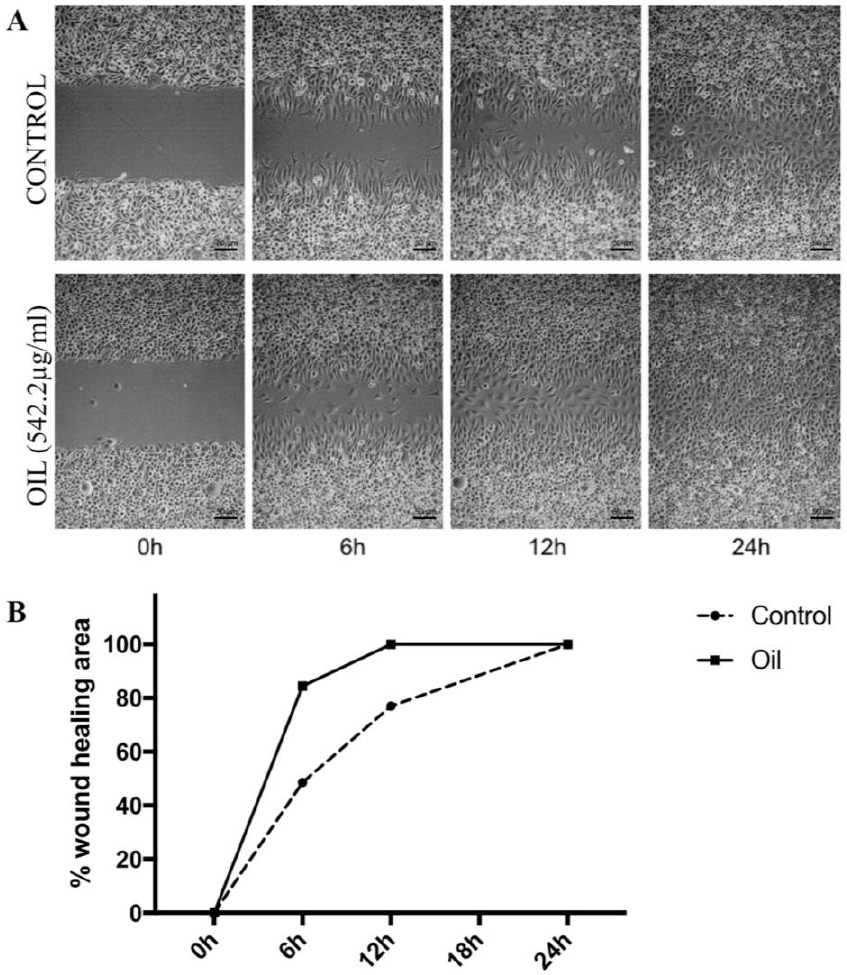
Figure 4. Effects of essential oil from E. dysenterica leaves on migration changes in L929 fibroblast cells after treatment monitored by phase contrast microscopy. A scratch wound healing assay was performed on L929 cells treated with 542.2 µg/mL of oEd to determine cell migration ability. Showing scratch wounds in L929 cells at time 0 h and representing wound status 24 h after the initiation of the scratch when the cells were treated with the vehicle control and concentration of oEd. Wounds were created and oEd was added immediately. Wounds were evaluated at 6, 12, and 24 h after oEd administration. ( A ). Wound healing area was measured by calculating the wound area in each period and expressed as a percentage of the initial wound area at time zero, with extract compared to the control ( B ). The statistical analysis (One way ANOVA with Tukey’s test) compares treatment with control ( p < 0.005).